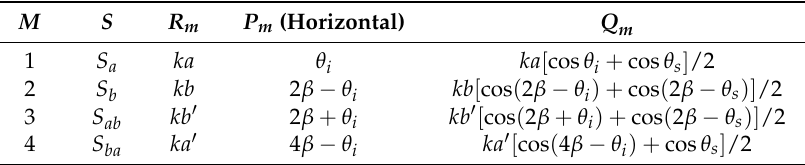
Table 1. Explanation of the parameters in Formula (29).